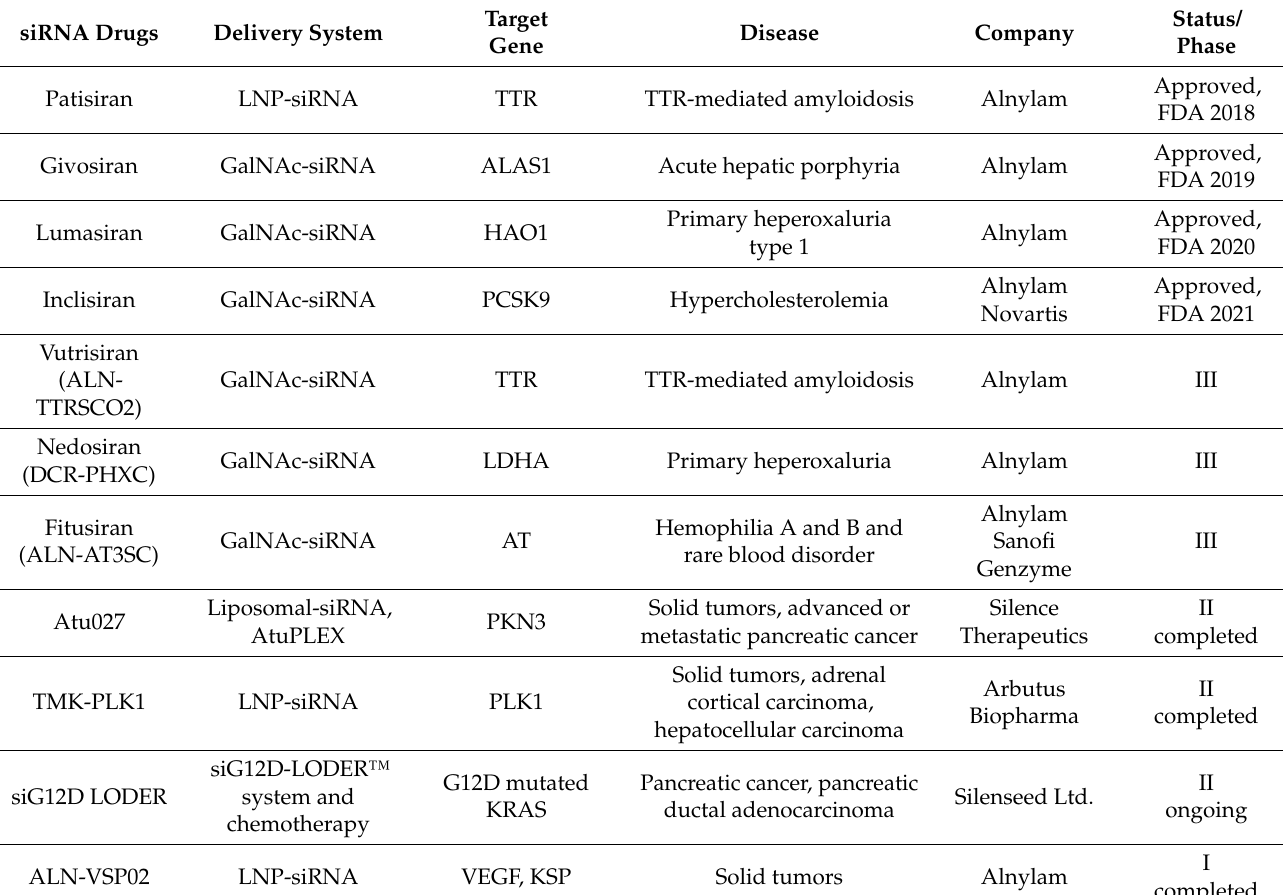
Table 1. siRNA therapeutics in different stages of clinical